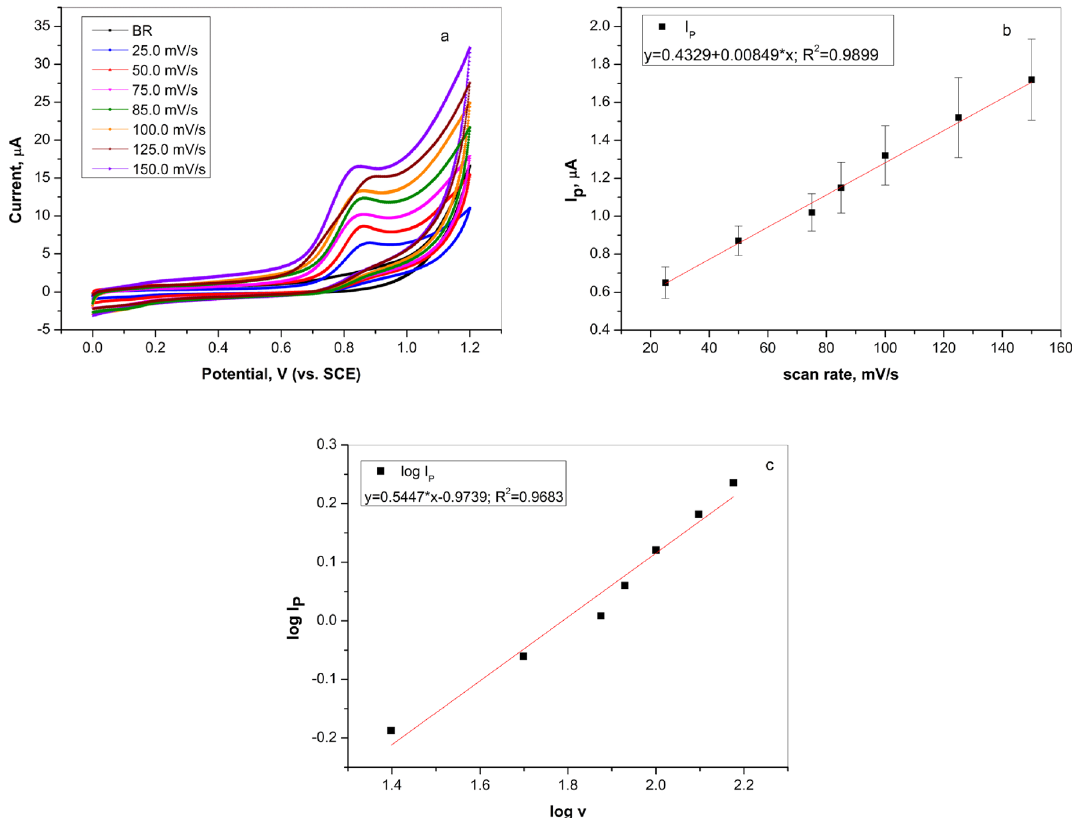
Figure 4. ( a ) Cyclic voltammetry curves of 100.0 µM L-tryptophan on graphite electrode in Britton– Robinson buffer solution (pH 4.0) at different scan rates (from 25.0 to 150.0 mV/s); ( b ) Dependence of peak current of 100.0 µM L-tryptophan on the scan rate; ( c ) Dependence of logarithm of peak current of 100.0 µM L-tryptophan on logarithm of scan